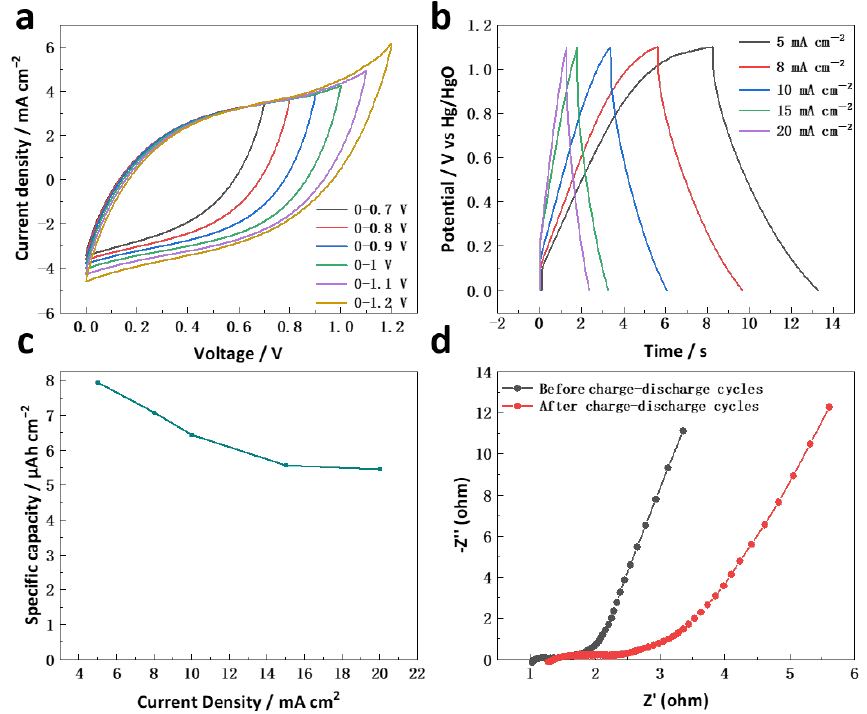
Figure 6. ( a ) CV curves measured at different operating voltages at 100 mV s − 1 , ( b ) GCD curves collected over different current densities, ( c ) capacities vs. current densities, ( d ) Nyquist plot of the same before and after 10,000 charge–discharge cycles.